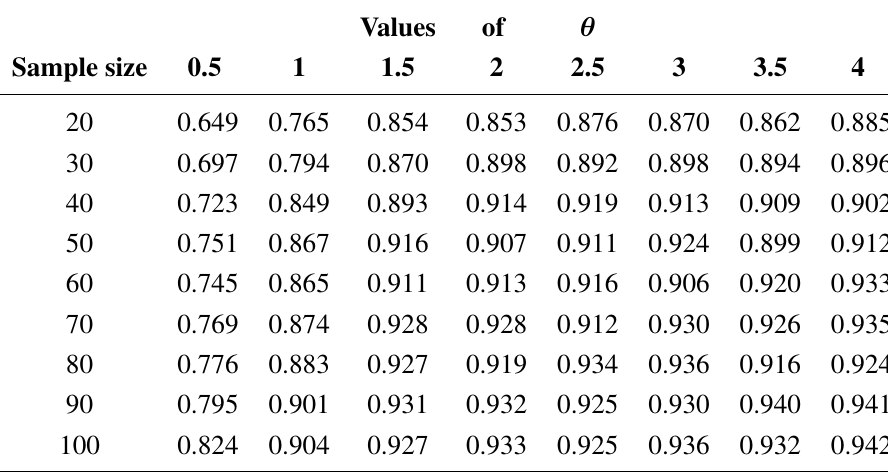
Table 3. Estimated coverage probability of the 95% confidence intervals for the variance parameter, σ 2 , using the observed information